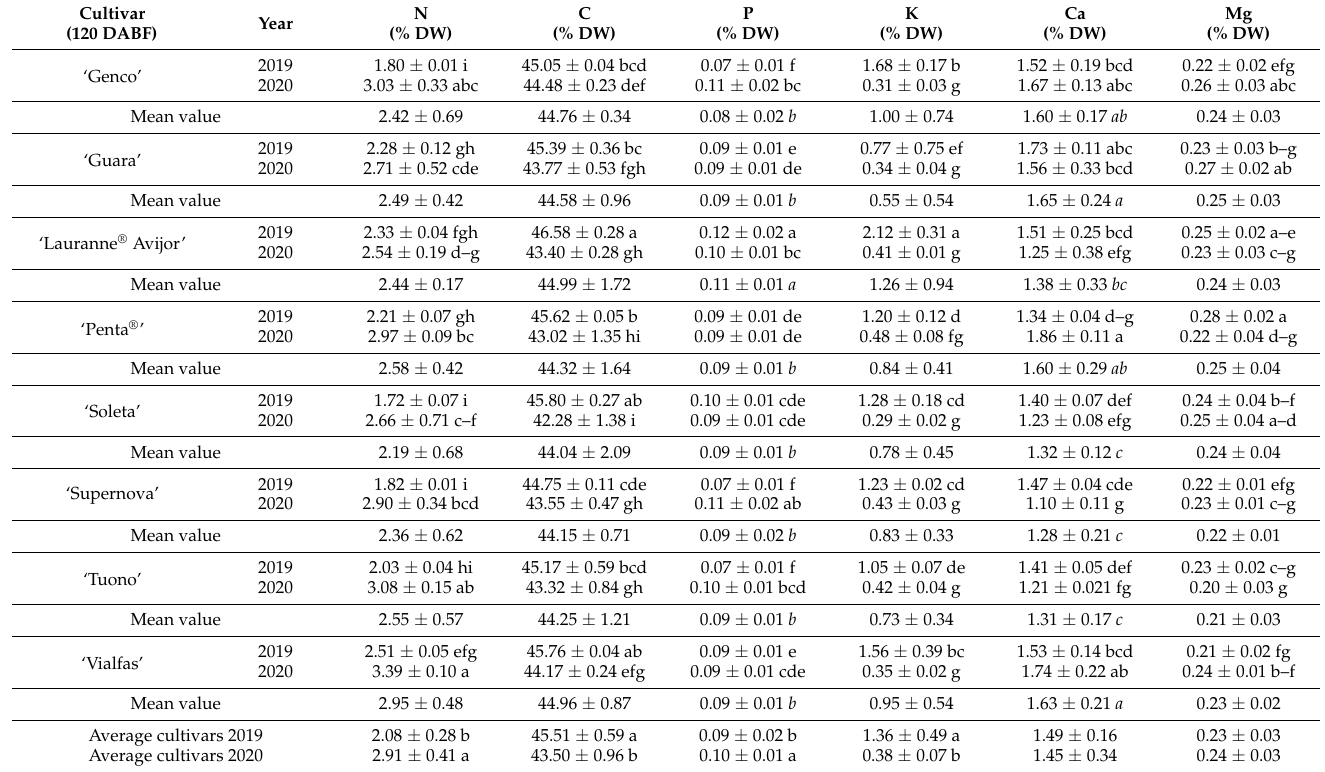
Table 5. Macronutrients content (% DW) in almond leaves collected at 120 DAFB over the years 2019–2020. (N = nitrogen, C = carbon, P = phosphorus, K = potassium, Ca = calcium, Mg = magnesium). Data are presented as mean ± standard deviation. Different lowercase letters on the columns indicate significant differences between means (Fisher’s test p < 0.05). Lowercase letters in italics describe the differences expressed as two-year mean values of the